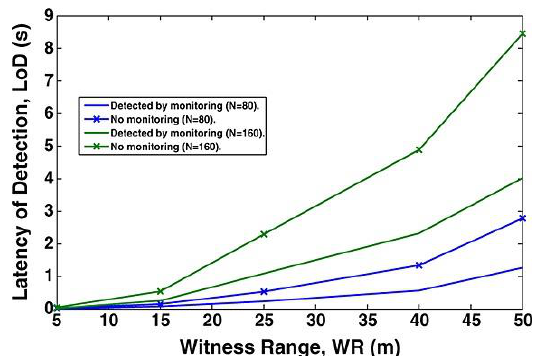
Fig.11. Impact of witness range on latency of detection